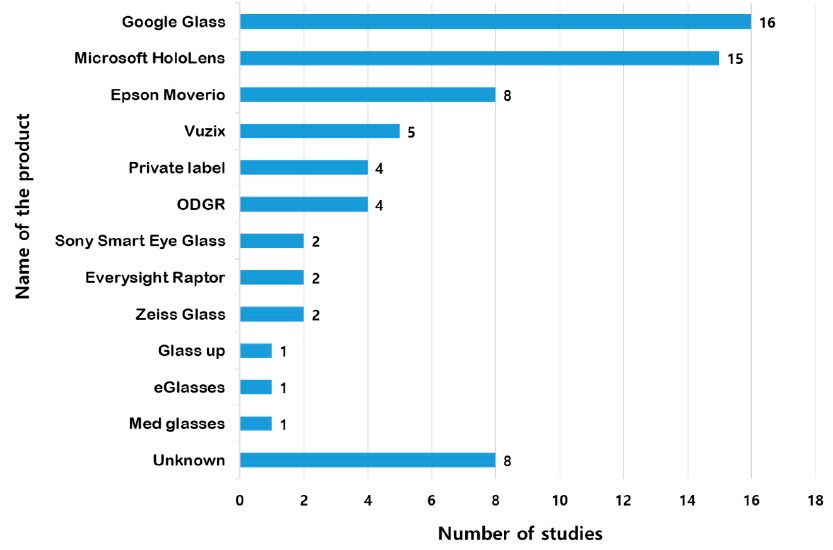
Figure 13. Frequency of use based on model of smart glasses. Figure 12. Frequency of use based on model of smart